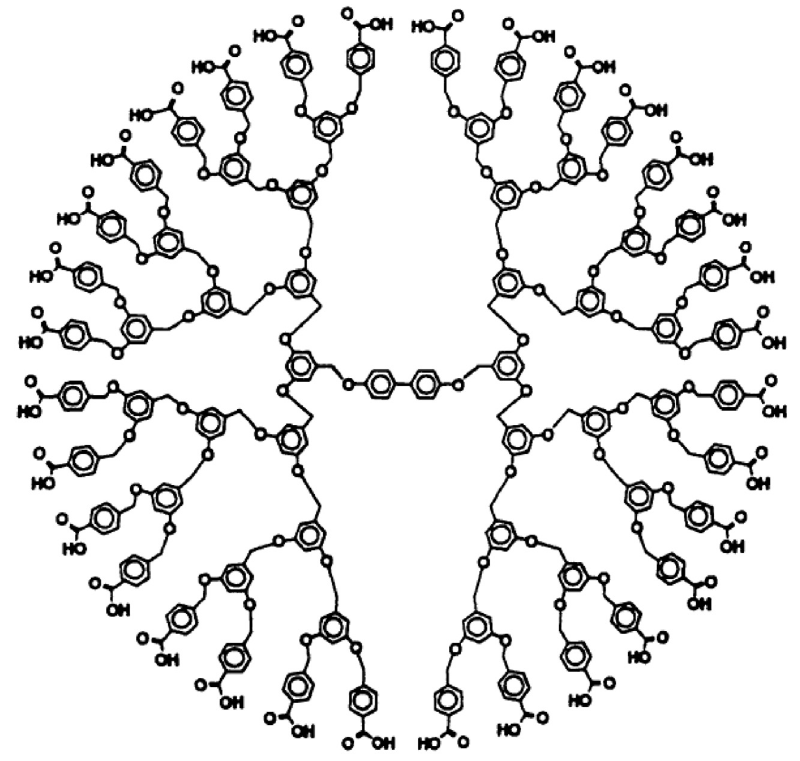
Figure 1: Carboxy-terminated dendritic macromolecule for n = 4.